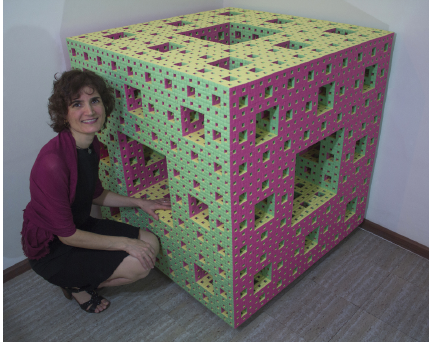
Figure 2. Level-4 origami Menger sponge.